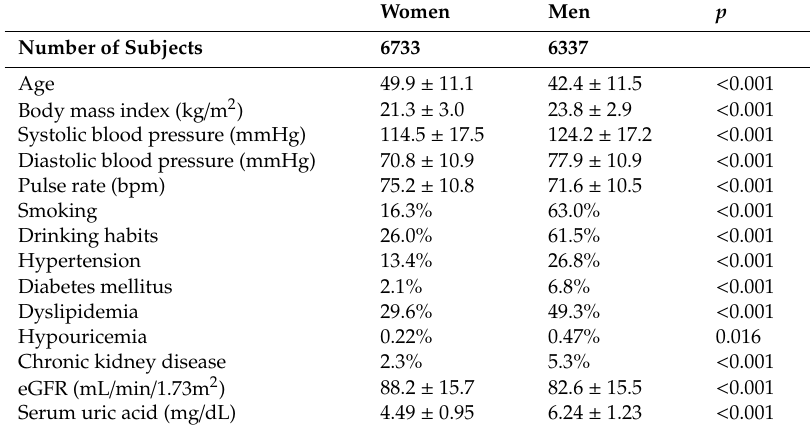
Table 1. Demographics of study subjects at baseline